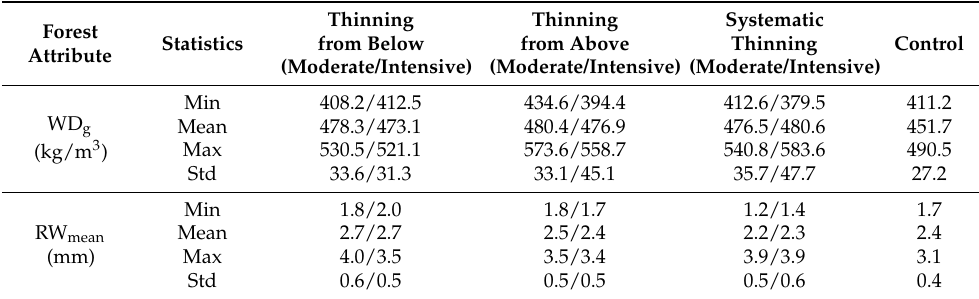
Figure 2. Boxplot figures for ring basal area weighted mean wood density (WD g ) and mean ring width (RW mean ) between different thinning treatments (i.e., moderate below (1), moderate above (2), moder- ate systematic (3), intensive below (4), intensive above (5), intensive systematic (6), no treatment (7)) showcasing the distributional characteristics (i.e., the minimum, the maximum, the sample median, and the first and third quartiles) of each group and possible outliers. Table 4. Statistics (minimum, maximum, mean and standard deviation) of ring basal area weighted mean wood density (WD g ) and mean ring width (RW mean ) between different thinning treatments. Moderate refers to thinning guidelines applied in Finland [43] whereas intensive results in 50% lower remaining basal area (m 2 /ha) compared to moderate thinning. Control refers to plots without thinning treatments since the